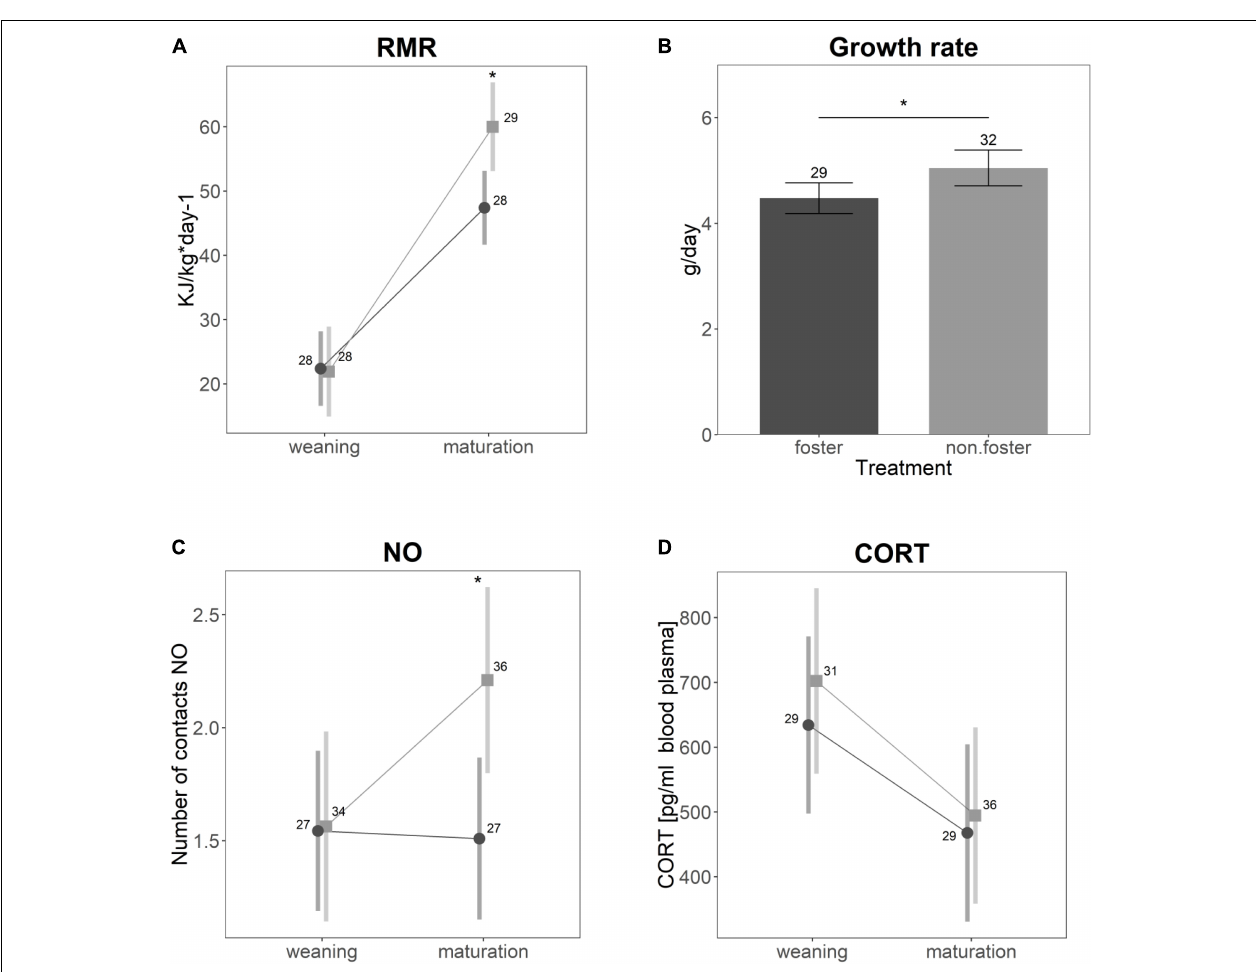
FIGURE 2 | Differences between the animals of Experiment I (non-fostered) in light gray and animals cross-fostered to the same size ranks ( Experiment II ) in dark gray for (A) specific resting metabolic rate, (B) growth rate, (C) number of contacts to a novel object, and (D) basal cortisol levels. Shown are the estimated values derived from the mixed models ± confidence intervals. Asterisks indicate significant differences. Samples sizes are given in the plot.